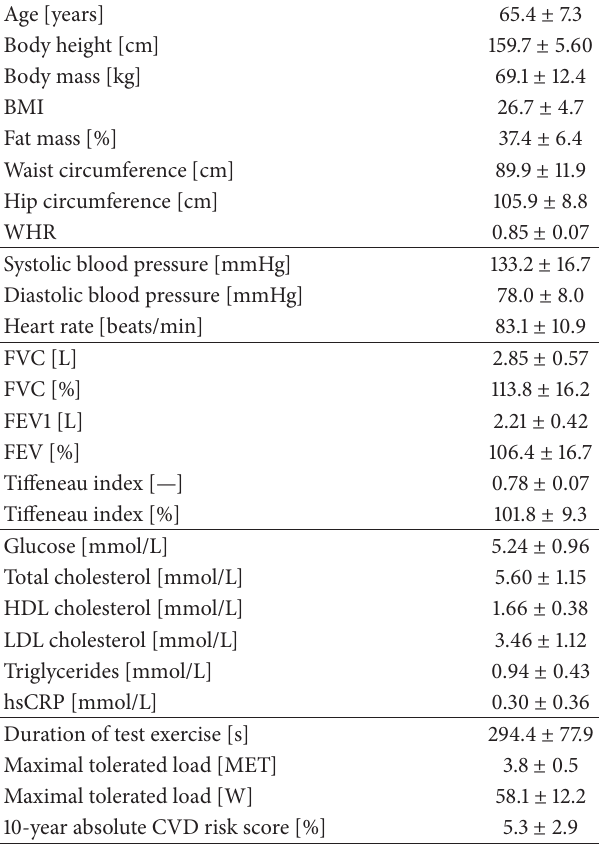
Table 1: Baseline subjects’ characteristics (mean ± SD); 𝑛 = 35